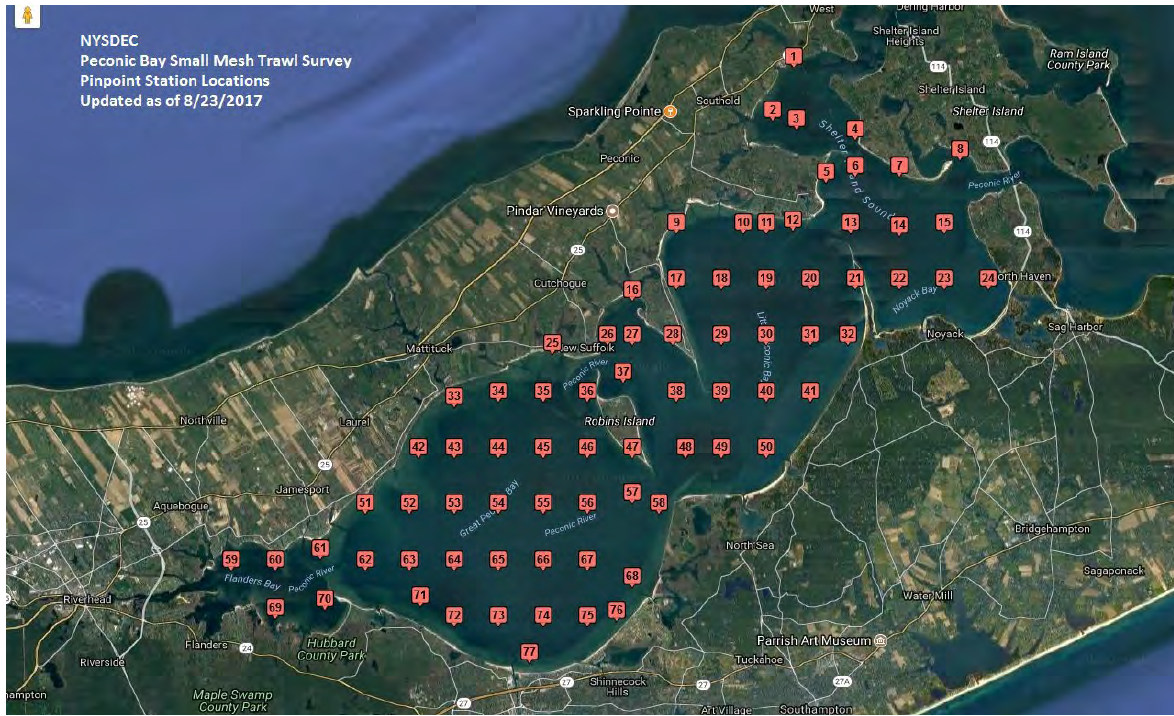
Figure 32. Map of New York Peconic Bay Small Mesh Trawl Survey Sampling